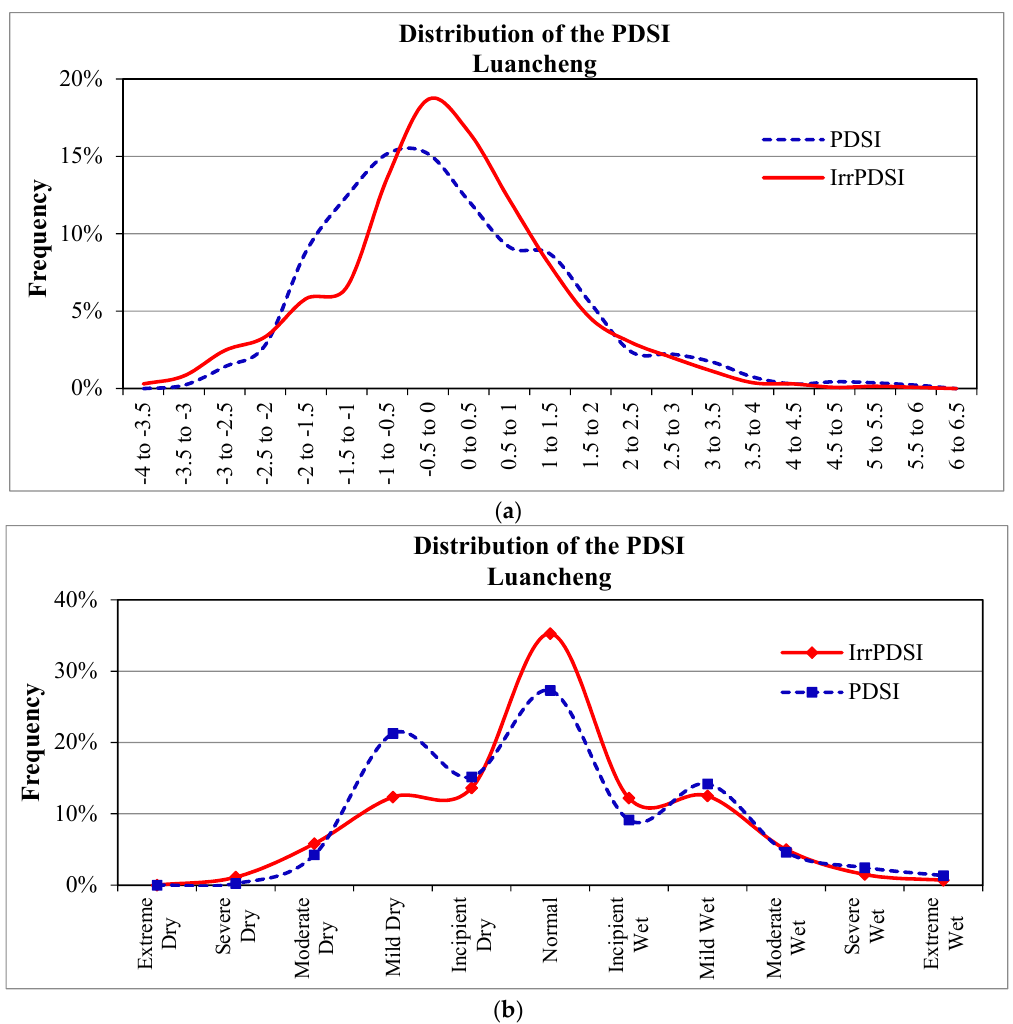
Figure 6. Plots showing the frequency of the two weekly PDSI values ( a ) over the entire range of PDSI values and ( b ) over the major PDSI categories for Luancheng.